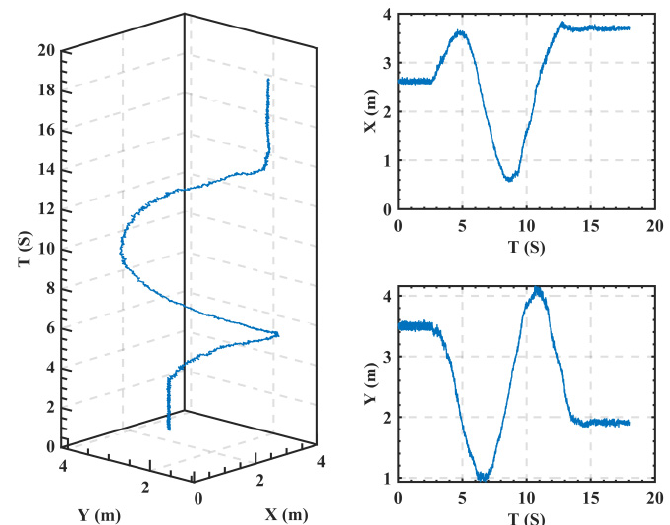
Figure 9. The test results of the moving body trajectory coordinates. The left picture gives the motion trajectory, the upper-right figure gives the X -coordinate, and the lower-right figure gives the Y